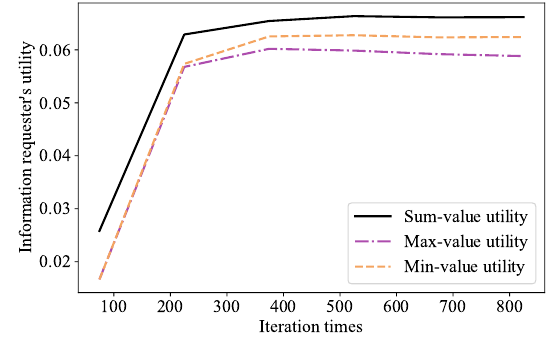
Figure 9. Comparison of sum-, max-, and min-value